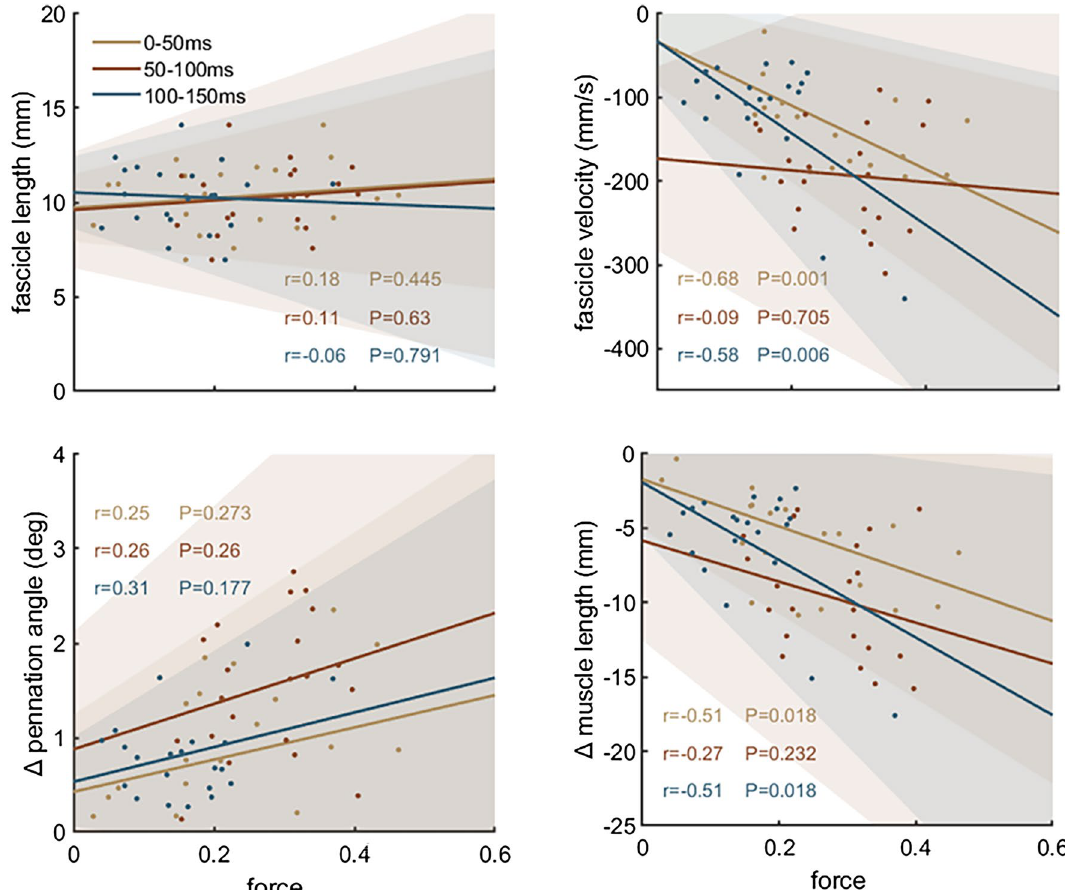
Figure 3. Correlation analysis between normalised force increase (to maximum force) during rapid contractions and optimal fascicle length, fascicle velocity, change in pennation angle and muscle length change (n = 21). Optimal fascicle length was defined as fascicle length at the greatest force. Fascicle velocity, pennation angle and muscle length values were determined during the respective time Fig. 3 for all time intervals. Optimal fascicle length was not related to force increase to 150 ms ( r = 0.11, P = 0.632) or to force increase at any time interval for absolute and normalised force. There were also no significant cor- relations between pennation angle and force increases ( r = 0.13–0.34, P > 0.1). Fascicle shortening velocity was negatively correlated with force increase for all intervals and for the whole period (0–150 ms; r = 0.52, P = 0.016),